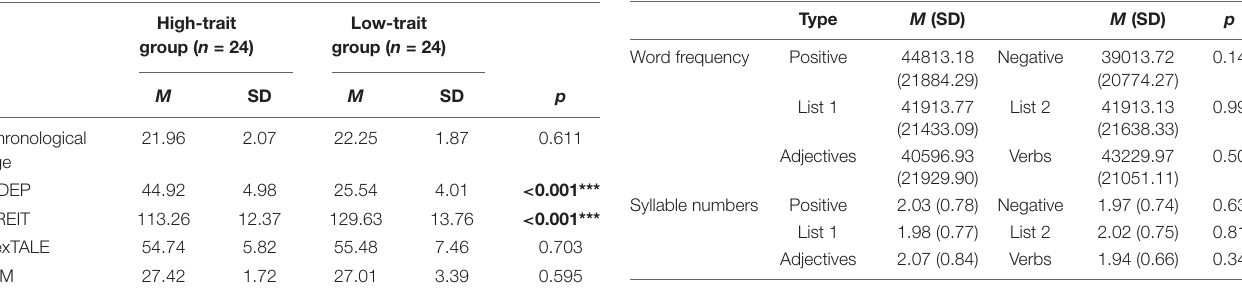
TABLE 1 | Basic information of participants. TABLE 2 | Word frequency and syllable numbers of selected English